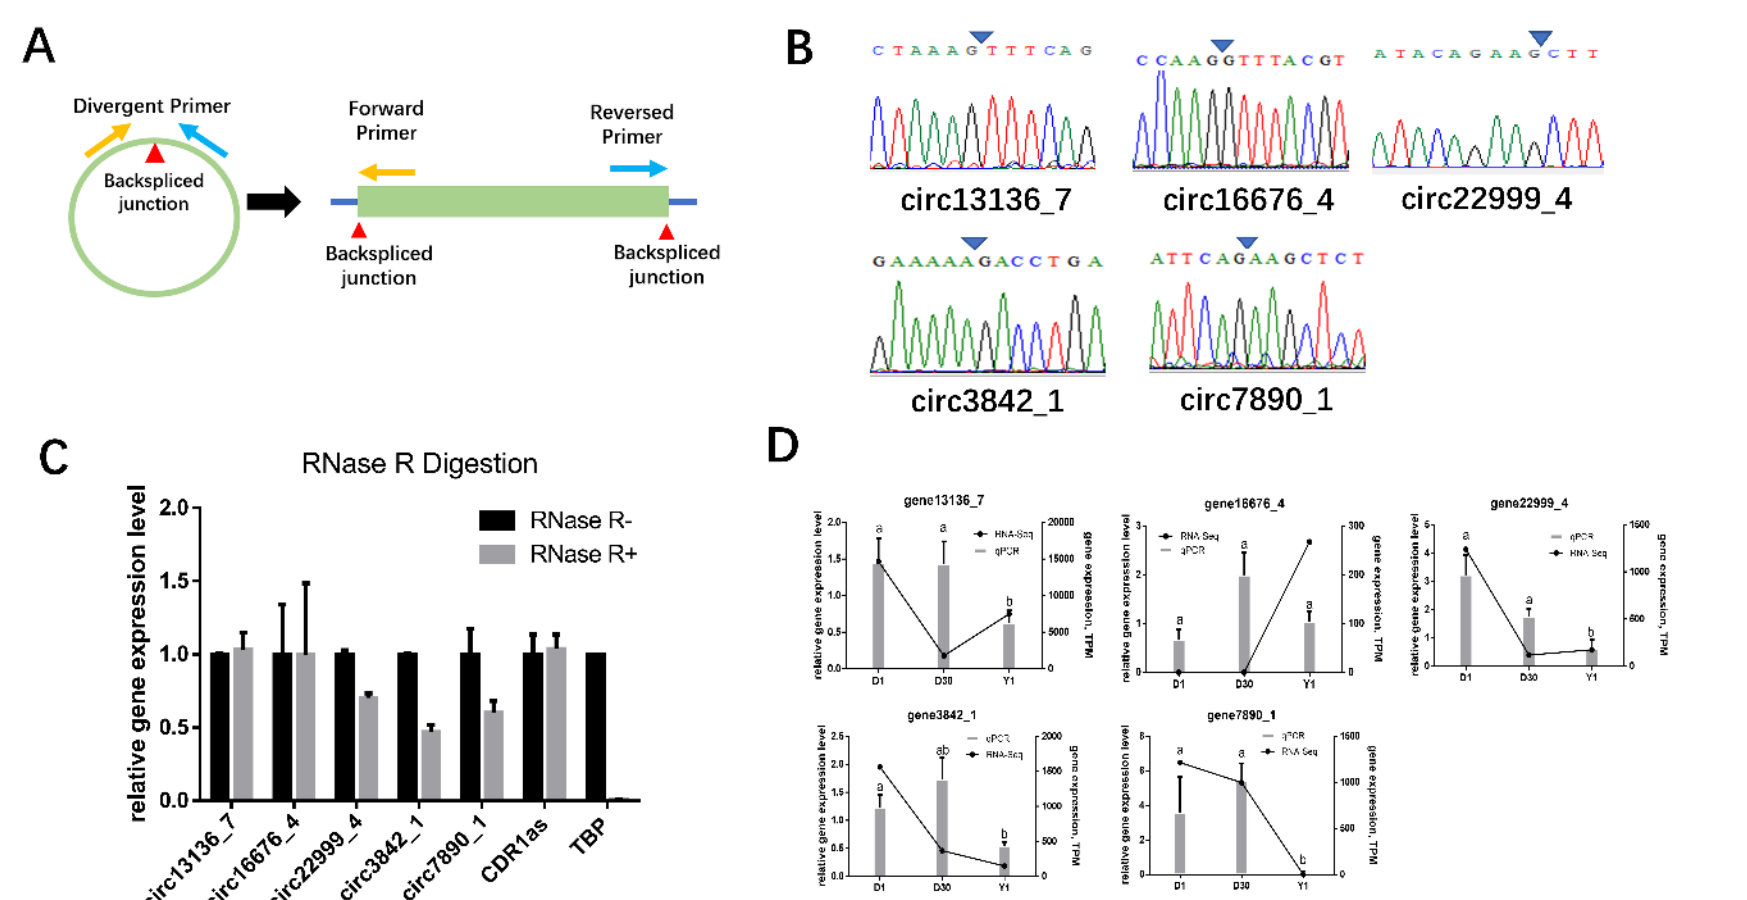
Figure 5. Validation of circRNAs. ( A ) Schematic representation of divergent primer. Orange arrows represent the forward primer whereas the blue shows reversed primer, the red triangle point to the back spliced junction. ( B ) Sanger sequencing shows head-to-tail junctions. Blue triangle shows back spliced junctions. ( C ) RNase R digestion assay. TBP was acted as negative control whereas CDR1as acted as positive control. Data were normalized according to the value measured in the mock treatment. ( D ) Validation of five DEcircRNA expressions via qPCR. Column shows qPCR results whereas RNA-seq data are shown as polyline. Error bars represent standard error of mean (SEM), n = 4. The superscript in the histogram showed the significance, different letters revealed that genes expressed conspicuously different among each other ( p < 0.05).